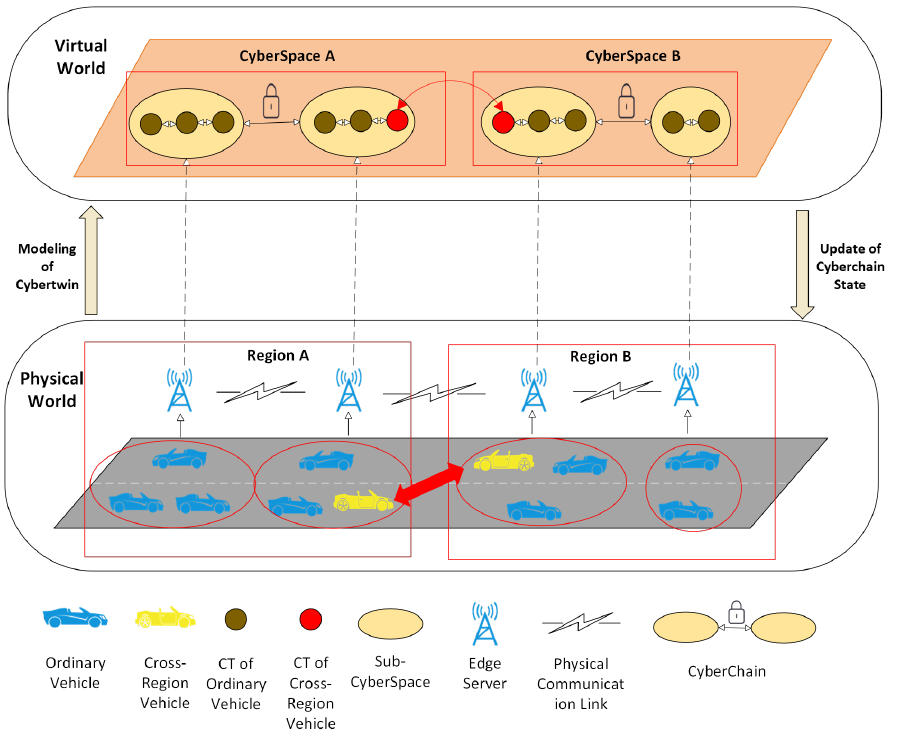
Figure 12. CyberChain: Cybertwin Empowered Blockchain for Lightweight and Privacy-Preserving Authentication proposed in